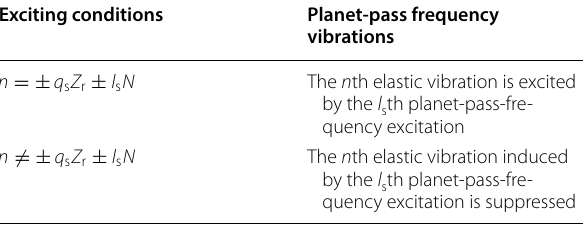
Table 2 Exciting conditions for elastic planet-pass